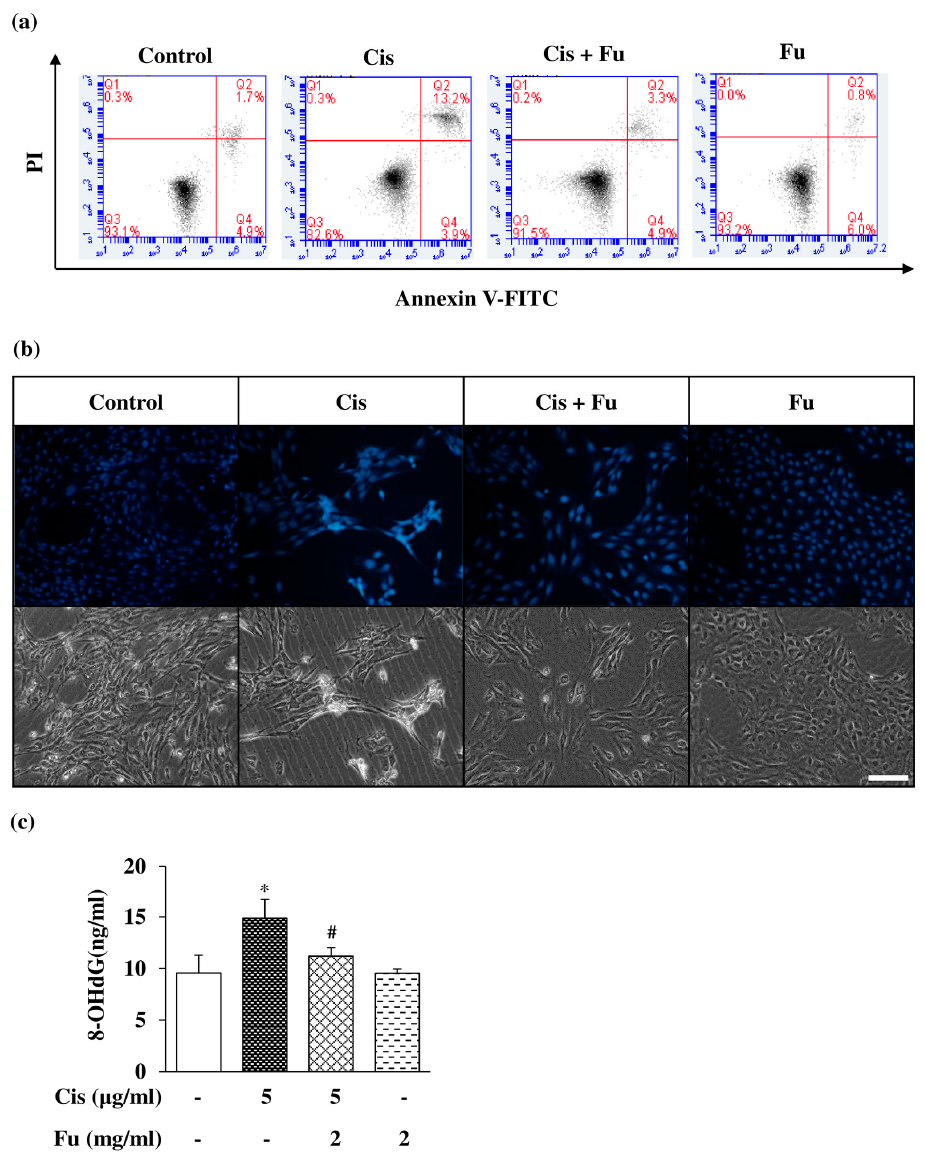
Figure 4. Effects of Fu on Cis-induced apoptosis of UB/OC-2 cells. Cells were cultured with Fu (2 mg/mL) for 2 h, followed by stimulation with Cis (5 µ g/mL) for 24 h. ( a ) Apoptotic cells were analyzed using an Annexin V-FITC Apoptosis Detection Kit via flow cytometry. ( b ) Apoptotic nuclei that exhibited condensed or fragmented DNA were stained with Hoechst 33258 and observed under a fluorescence microscope (×200). Scale bar =100 μ m. ( c ) The extent of oxidative DNA damage was assessed using an 8-OHdG ELISA Kit. The results are expressed as the mean ± SD. n = 3 per group. * p < 0.05 vs. the control group; # p < 0.05 vs. the cisplatin group. Fu, fucoidan; Cis, cisplatin; 8-OHdG, 8-hydroxy-2-deoxyguanosine; PI, propidium iodide; FITC, fluorescein isothiocyanate.